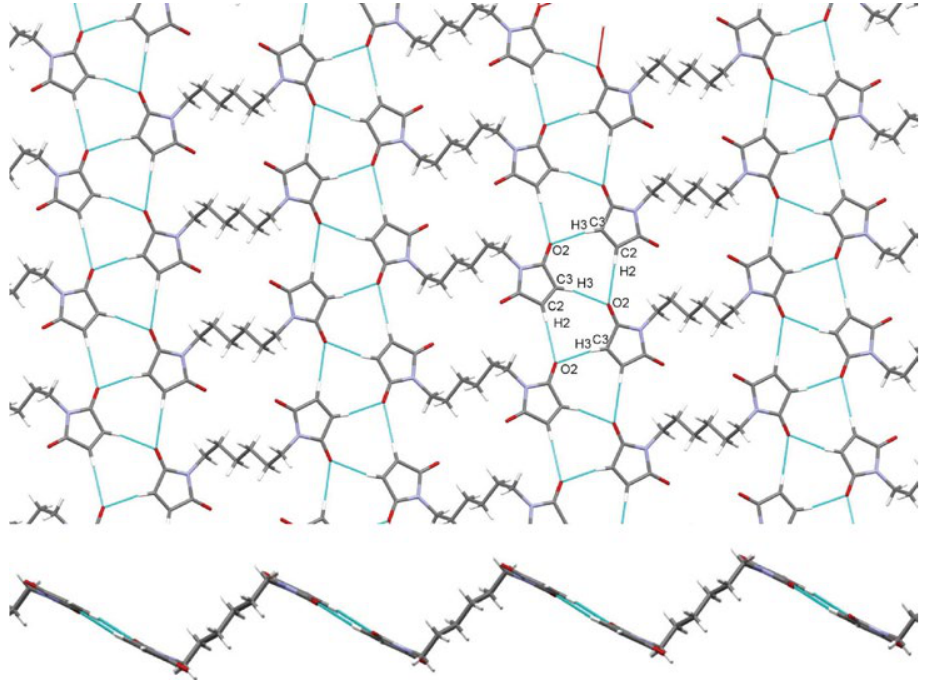
Figure 3. 2D layer formation in 2b generated by C–H···O hydrogen bonding (blue dashed lines) with graph set motif R 2 layer (bottom).